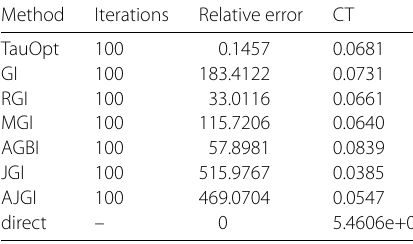
Table 4 Relative errors and CTs for Ex.